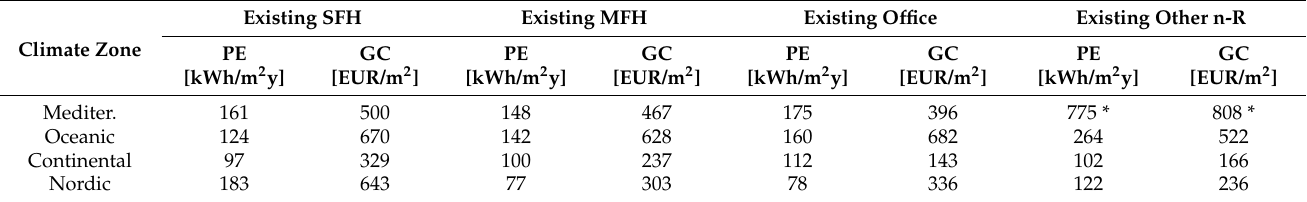
Table 5. Average cost-optimal levels (PE: Primary Energy and GC: Global Cost) for existing buildings per climatic